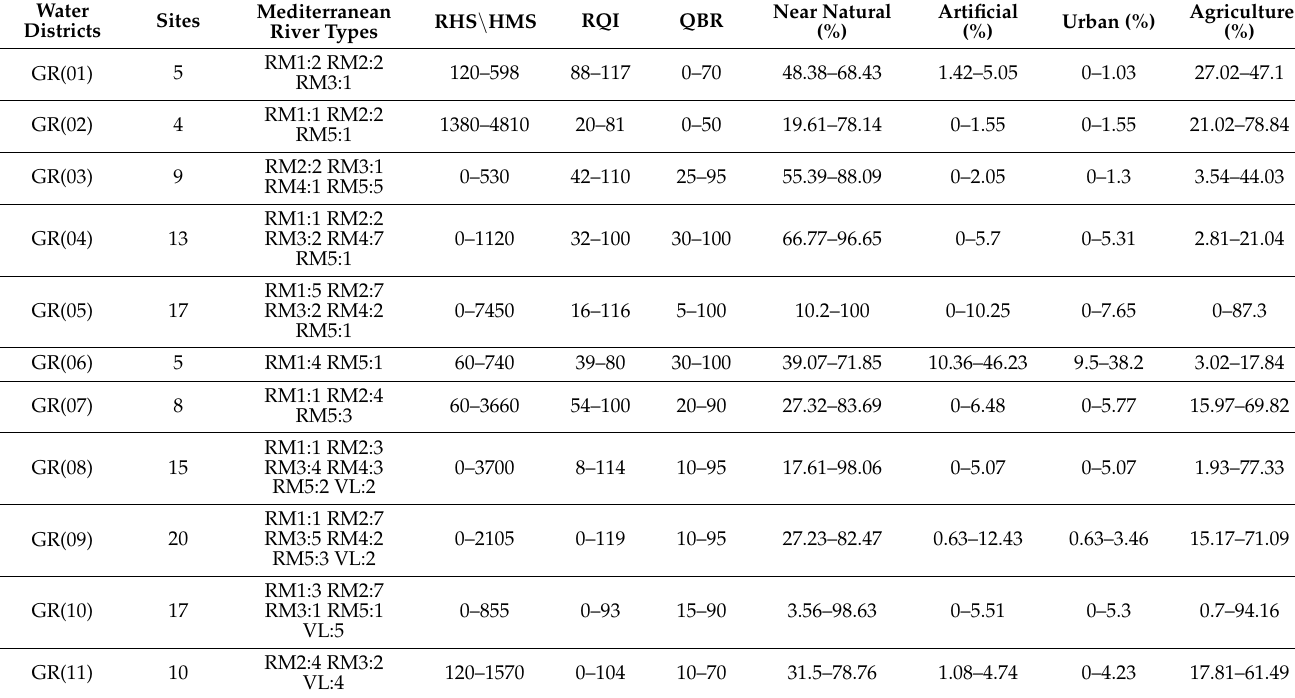
Table 4. Main parameters of the examined data set for each Water District (GR01: Western Peloponnese, GR02: Northern Peloponnese, GR03: Eastern Peloponnese, GR04: Western Central Greece, GR05: Epirus, GR06: Attica, GR07: Eastern Central Greece, GR08: Thessaly, GR09: Western Macedonia, GR10: Central Macedonia, GR11: Eastern Macedonia) and each Mediterranean River Type according to Van de Bund [33] and Lazaridou et al. [34] (R-M1: Small–mid altitude Mediterranean streams (<100 km 2 catchment area) with strong seasonal flow, R-M2: Small mid-lowland Mediterranean streams (100–1000 R-M4: Small–mid Mediterranean mountain streams with strong seasonal flow, R-M5: Small lowland temporary streams with temporary flow, VL: Very Large Rivers: (>10,000 km 2 catchment area).